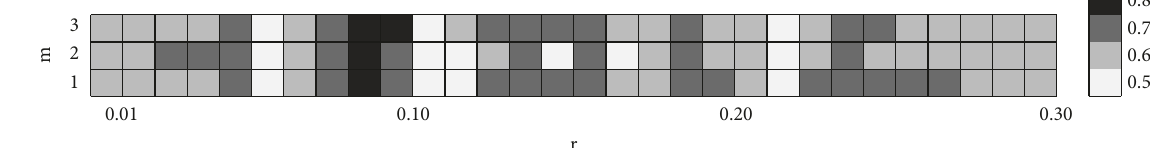
Figure 3: AUC values obtained for SampEn with 𝑚 ∈ [1,3] and 𝑟 ∈ [0.01, 0.30] . Maximum is obtained for 𝑚 = 3 and 𝑟 = 0.09 , with AUC = 0.8430 , and 𝑝 = 0.0175 .